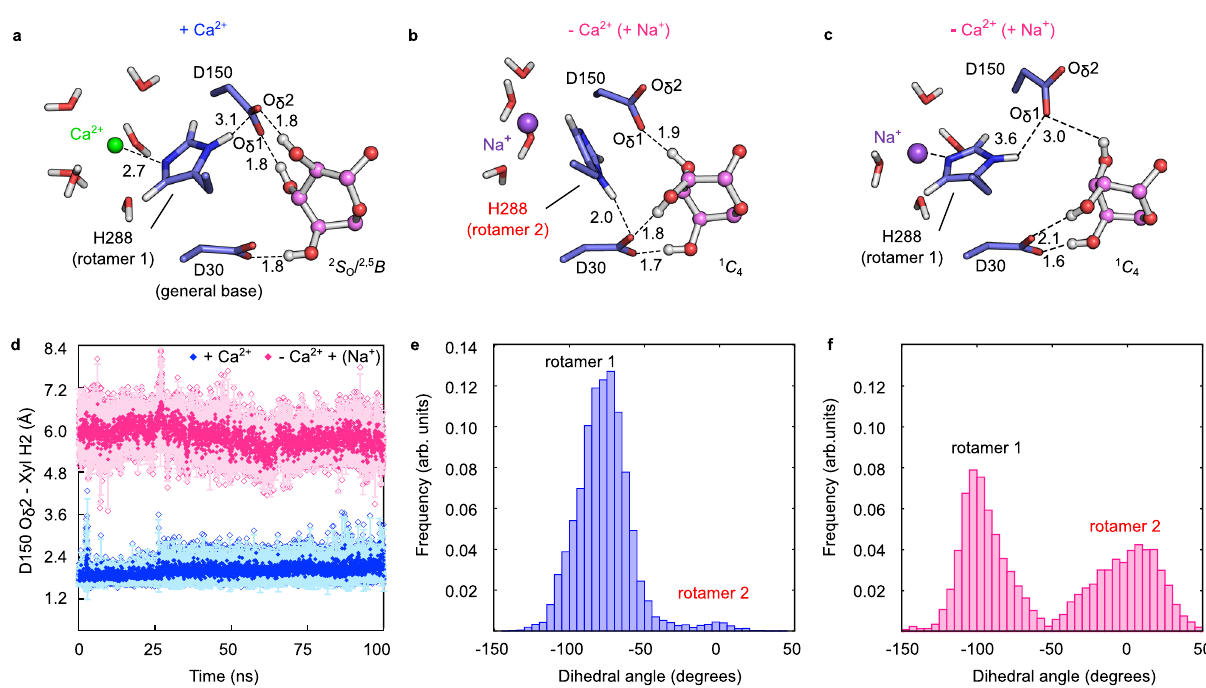
Fig. 5 Effects of the presence or absence of Ca 2 + ion in XacGH43_1 active site. a Representation of the − 1 subsite in the presence of Ca 2 + in the metal- binding site. b Snapshot of the MD simulation in which the Ca 2 + was initially replaced by a water molecule, followed by Na + (from the solvent) entrance to the metal-binding site. Here the His288 adopts a different conformation (rotamer 2) and interacts with Asp30 (general base) and Asp30 interacts with the xylosyl H2. c A snapshot from the same simulation of b, with the Na + being coordinated by His288. The interaction of Asp30-xylosyl H2 is maintained. Distances in a – c are represented in angstroms. d Distances between Asp150 O δ 2 and xylosyl H2 atoms during the production of the three MD independent simulations with Ca 2 + (blue) or with water (spontaneously replaced by Na + during the course of the simulation) (pink). Averages are shown as solid symbols and the SD with lighter colors. Data points are shown as empty symbols. e His288 dihedral angle distribution of the rotamers 1 and 2 during the MD simulation with Ca 2 + . f Same results in the MD simulation without Ca 2 + (spontaneously replaced by Na + during the course of the simulation). Source data are provided as a source data fi le.